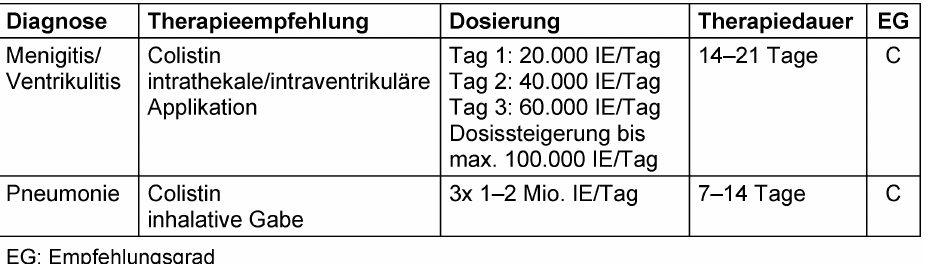
Tabelle 5: Spezielle Applikationsformen von